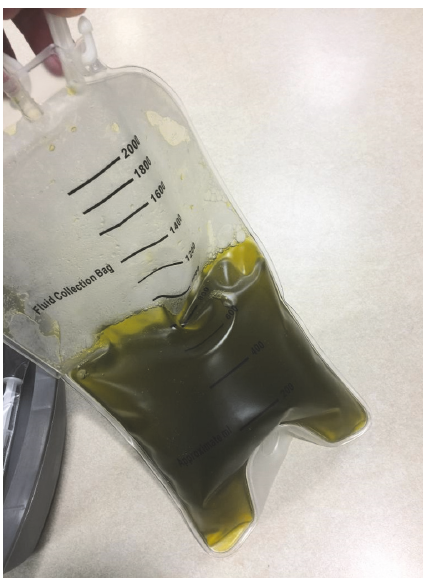
Figure 2: A thoracentesis yielded 900 cc of exudative bilious fluid.